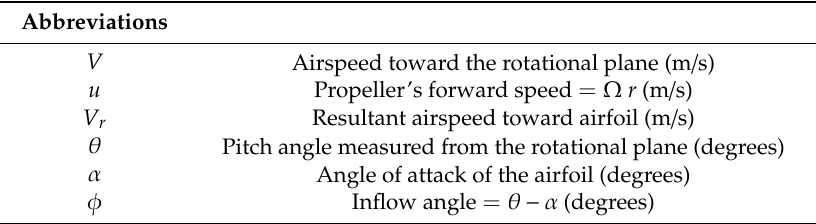
Table 1. Symbols used in propeller modeling.